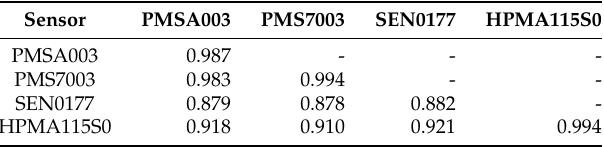
Figure A4. Correlation plot between inter/hetero sensors. Table A5. Comparison of the coefficient of determination with three sensors of four kinds each. After calculating the coefficient of determination for each combination of three sensors for each sensor type, the worst value was selected and calculated. (e.g., pmsa003-a,